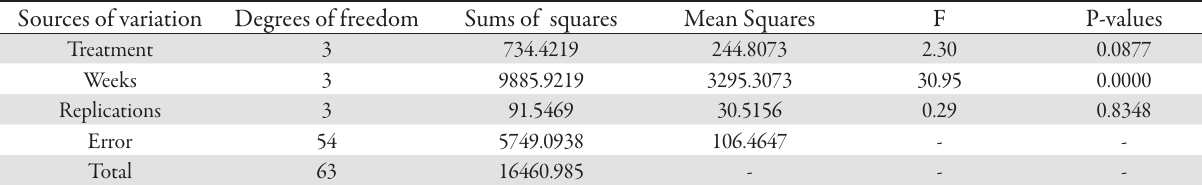
Tab. 4. Several qualitative and quantitative characteristics of the baked bread Type of